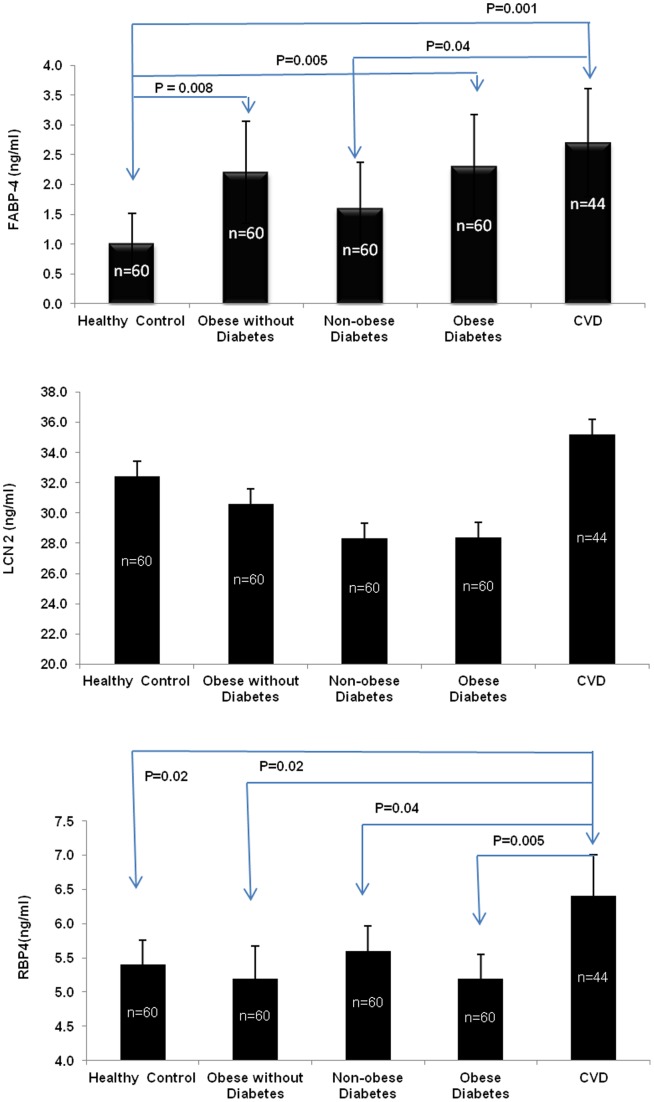
Serum levels of FABP4, LCN2 and RBP4 in obese subjects with or without diabetes and in CVD patients.The CVD group had significantly higher level of serum RBP4 compared to any of the other groups. FABP4 values were significantly higher in obese, obese diabetic and CVD subjects compared to control and non-obese diabetic groups. LCN2 values were higher in CVD subjects than any of the others but this difference did not reach statistical significance (P = 0.46).